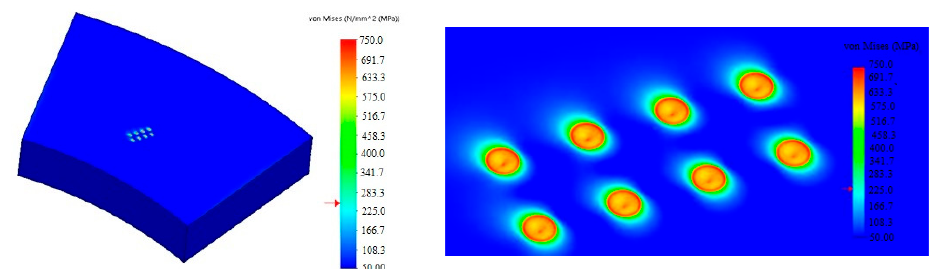
Figure 17. The stress field in the part of the thrust bearing disc and defect No. 3.